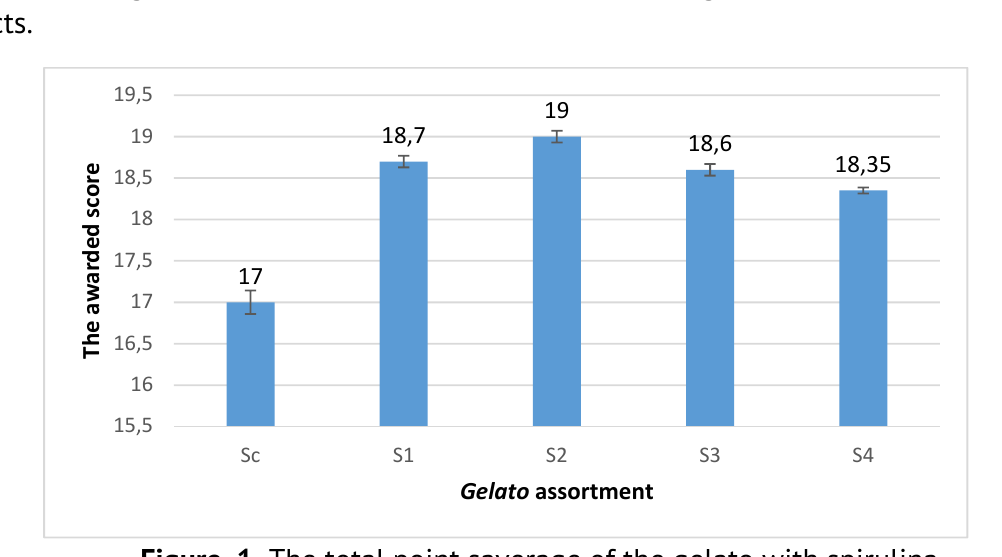
Figure. 1. The total point saverage of the gelato with